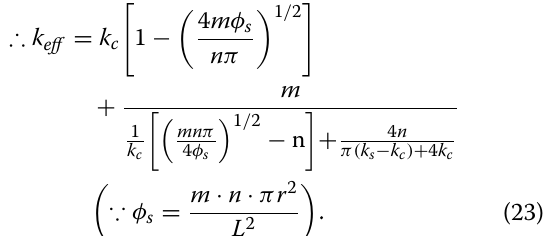
(Table 1) for the numerical simulations are based on the Korean design standard of buildings (Korean Ministry of Land, Infrastructure and Transport (KMOLIT) 2015). The numerical domain is a cube with side length 0.1 m. Thirty test cases are conducted with various Φ S and N re .